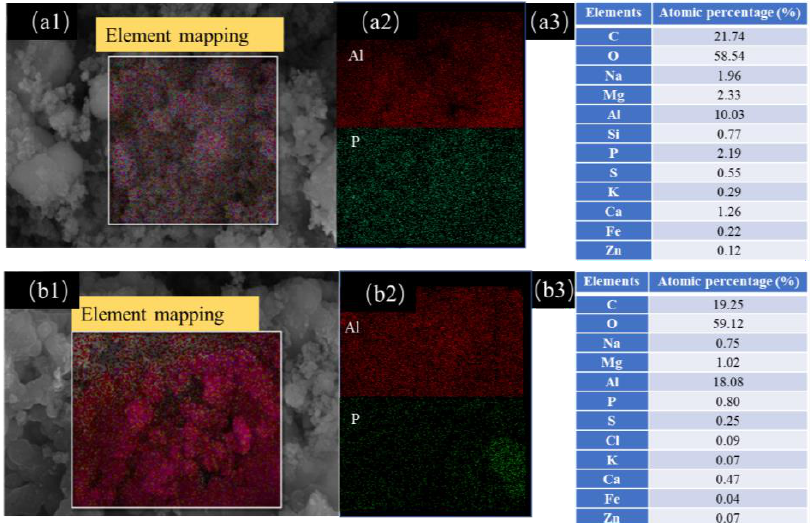
Figure 7. SEM of two kinds of precipitates (( a , b ) are precipitate 1, ( c , d ) are precipitate 2).